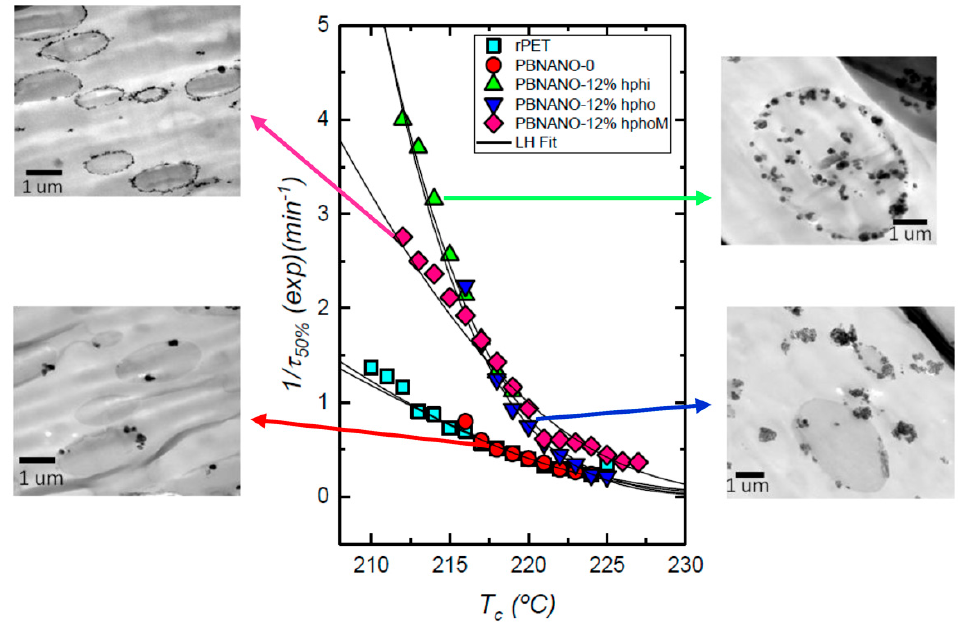
Figure 10. Overall crystallization rate of rPET and the rPET phase within the indicated PBNANOs as a function of crystallization temperature. Solid lines correspond to mathematical fits to the Lauritzen and Hoffman theory [41].